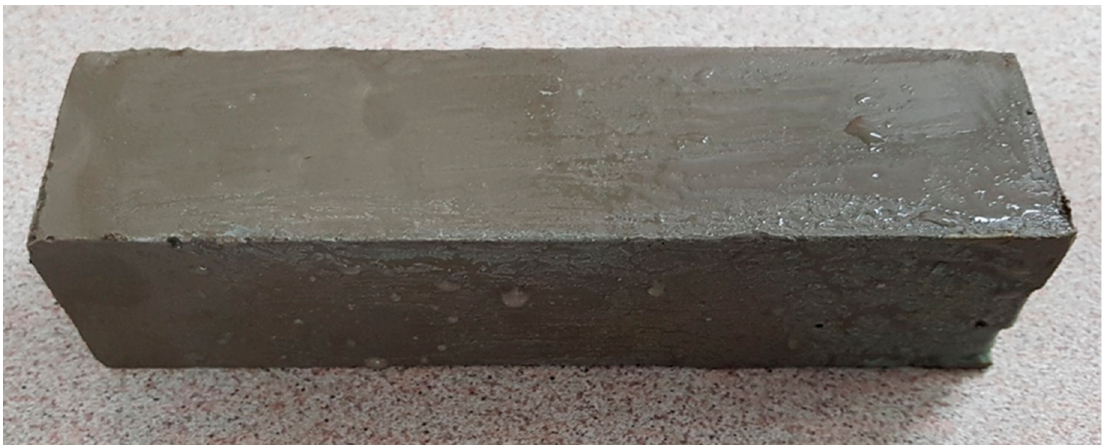
Figure 10. An example of a standard beam subjected to strength testing.